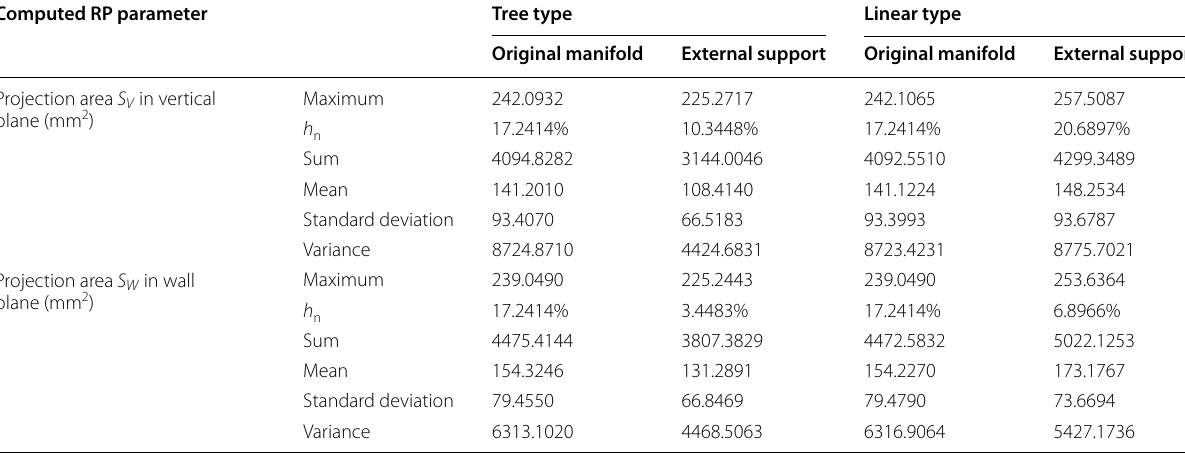
Table 2 Orthogonal projection area of different manifolds of tree type and linear